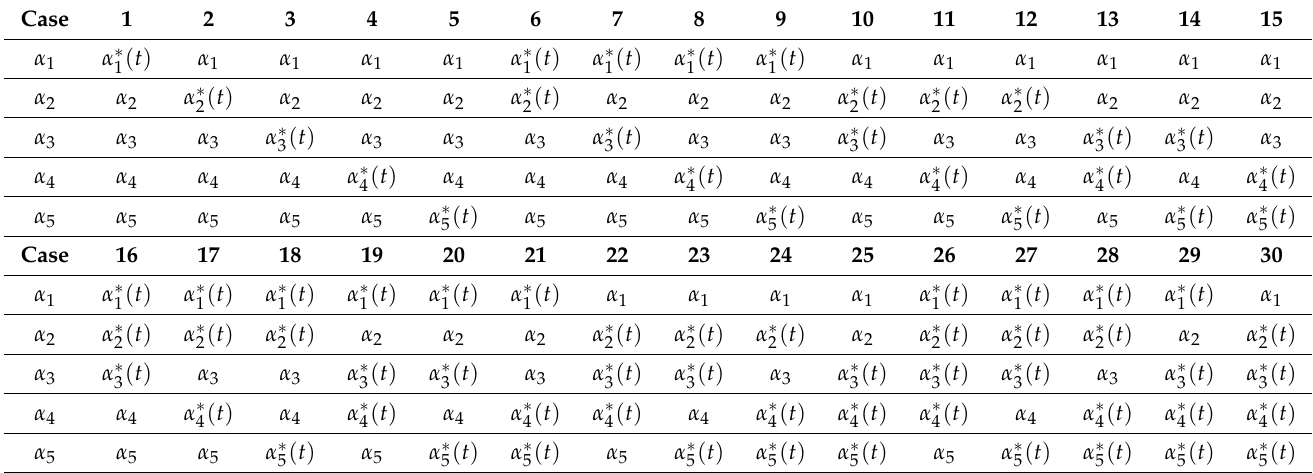
Table 4. Solutions of optimal control problems